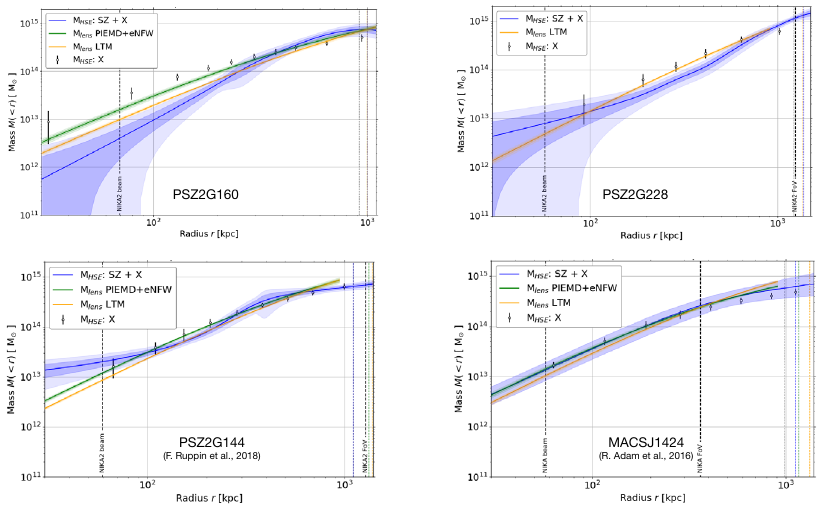
Figure 2. Reconstructed HSE mass profiles: in blue for SZ + X-ray combination and in white dots for X-ray only. Reconstructed lensing mass profiles for the two κ -map models in green and yellow. Vertical colored dashed lines represent the R 500 for each mass profile and black dashed lines NIKA(2) instrumental beam and field of view.